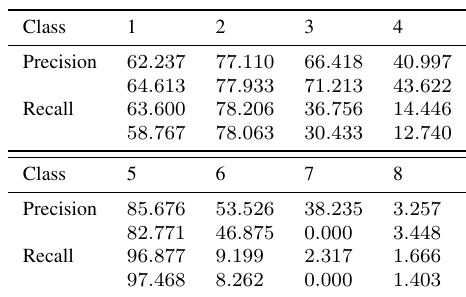
Figure 3. Architecture of the multi-branch 1D CNN. After each convolutional layer (input dimensions denoted in square brackets), a max pooling with F = 2 and S = 2 is performed. 16 , 32 and 64 denote the number of used kernels. For better visibility, please refer to the Table 2. Achieved accuracies (in %, first row) and inference digital version. times (in s, second row) per test tile. There is no time depicted for the MRF smoothing as its processing time is independent on provided predicted label distribution. The weighted arithmetic mean is given for accuracies only. Best performances are marked in bold. Please note, the class distribution from Tile D differs significantly from the training tiles leading to bad performance. Class distributions of residual test tiles are similar to training distribution.